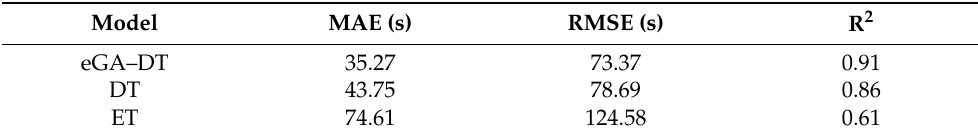
Table 4. Model performance by eGA–DT, DT, and ET.